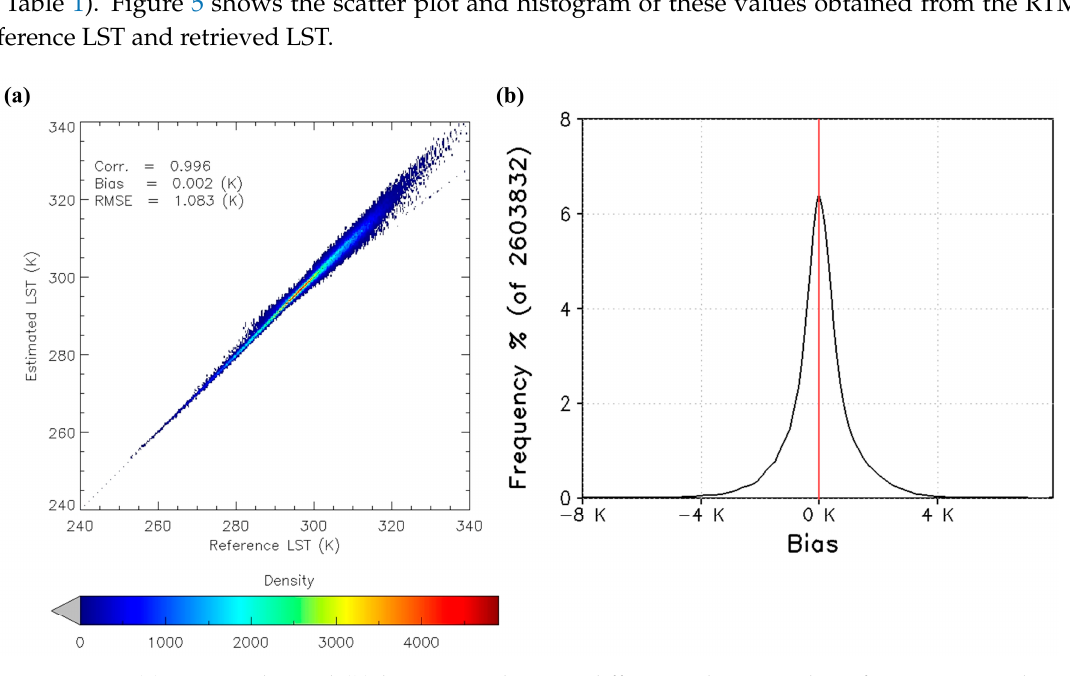
Figure 5. ( a ) Scatter plot and ( b ) histogram showing differences between the reference LST and estimated LST using the Himawari-8/AHI LST retrieval algorithm.